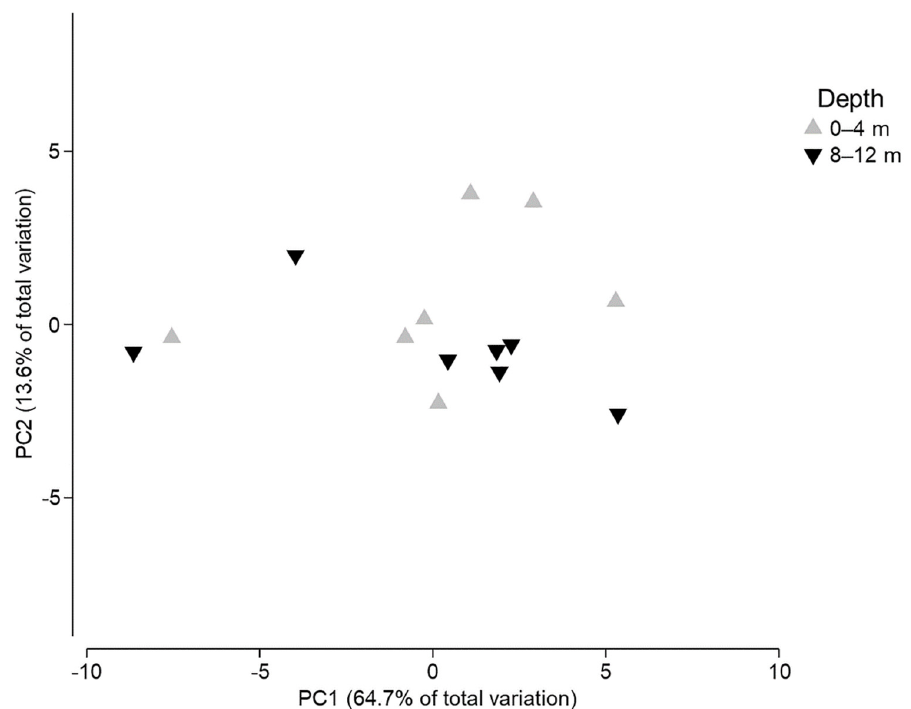
Figure 8. Principal components analysis (PCA) of fatty acid (FA) concentrations from samples of Elysia crispata collected at different depths in the Southern Gulf of Mexico. Elysia crispata collected at different depths in the Southern Gulf of